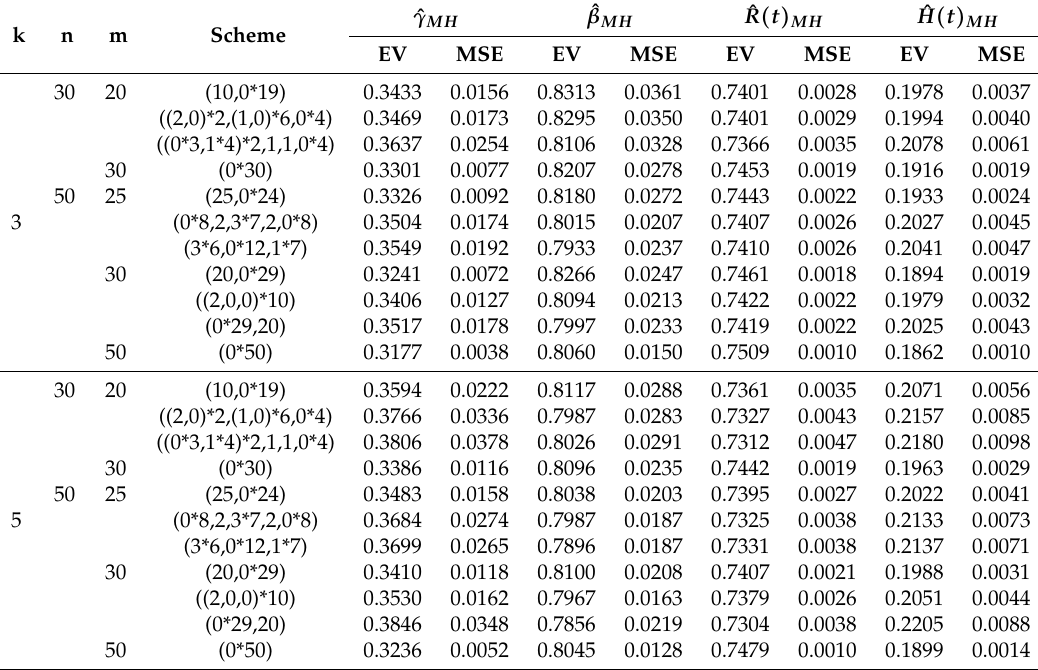
Table 15. Estimation values and MSEs of parameters, reliability and hazard functions using Metropolis-Hastings method under LLF when h = 1, γ = 0.3, β = 0.8, t = 1.5, a 1 = 1.08, b 1 =